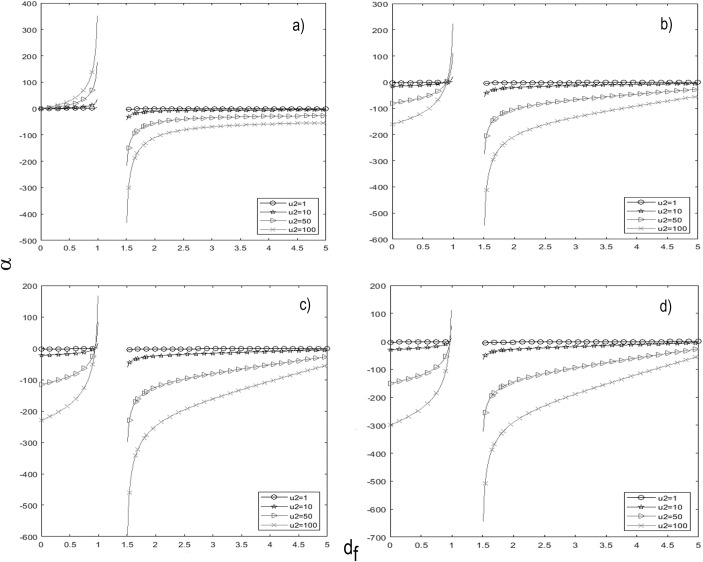
Simulation of Eq (9).For different values of u2 (1, 10, 50 and 100 days-1) it is plotted the graph of α (in days-1) versus df for (A) nobs = 1 cell. (B) nobs = 5 cells. (C) nobs = 10 cells. (D) nobs = 20 cells.